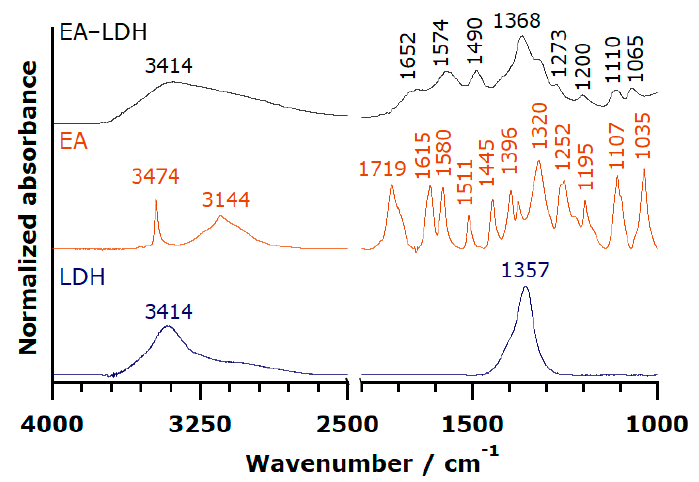
Figure 2. FT-IR spectra of EA-LD, EA, and LDH.